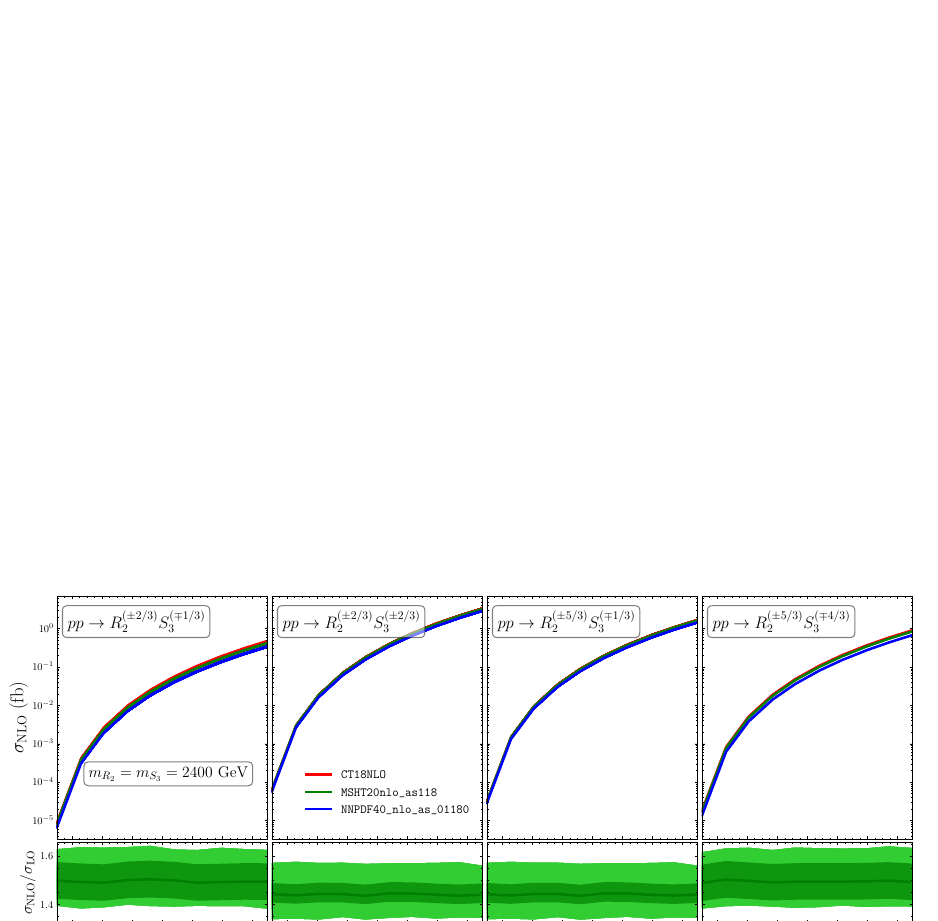
= m S = 2400 GeV 2 3